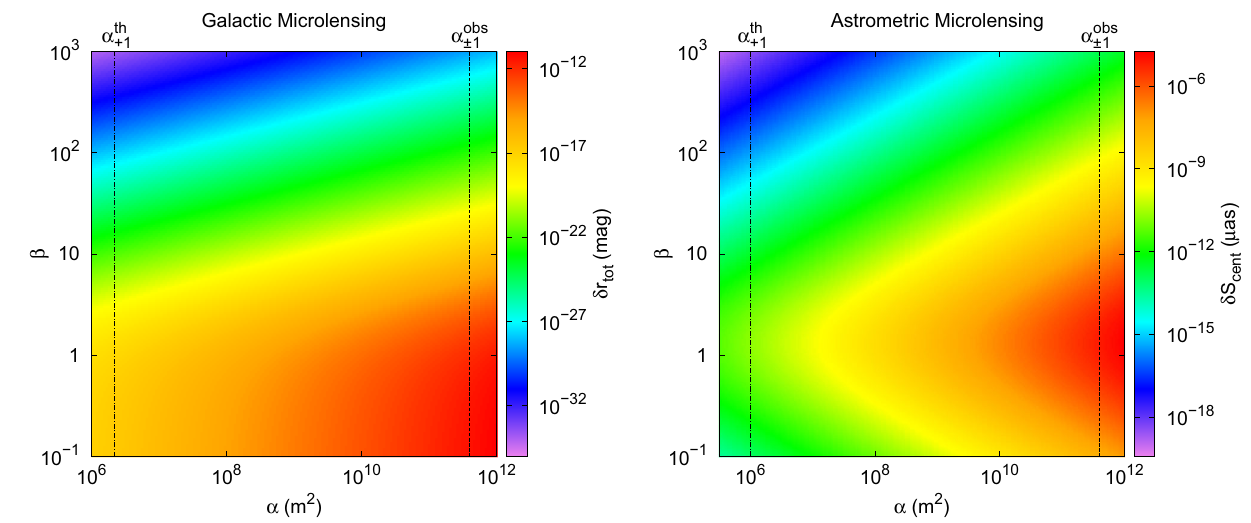
Fig. 2 Estimatedcontributionsinmicrolensingcausedbyphotonscou- pling to the Weyl tensor in the Schwarzschild black hole. Left: δ r tot is shown for a Galactic lensing with M • = M (cid:9) and 2 d L = d S = 8 kpc. Right: δ S cent is represented for an astrometric lensing with M • = 0 . 676